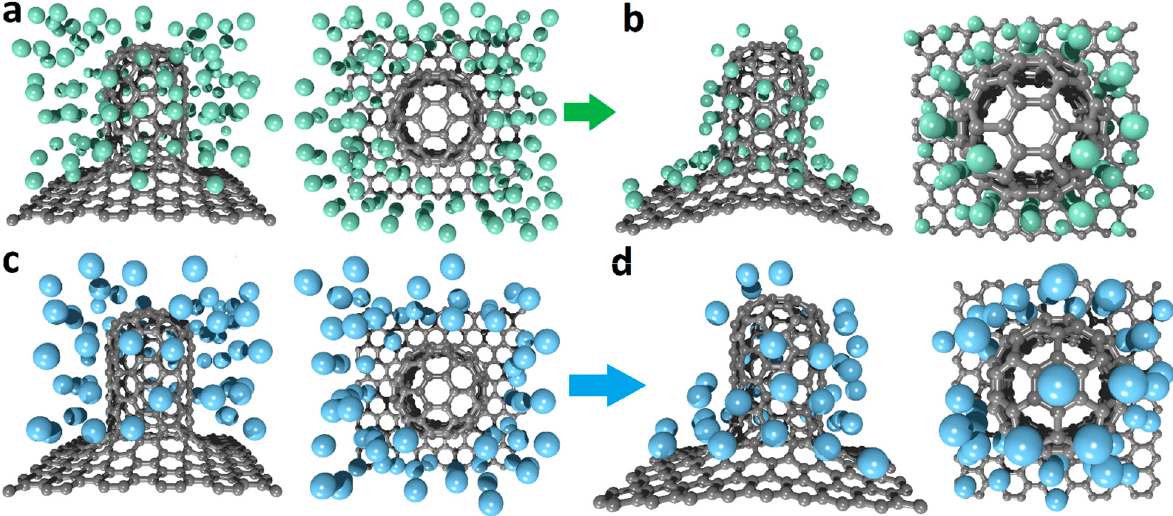
Figure 3. The process of filling the graphene–CNT composite with Li or Na atoms ( a , b ) and its ground state atomic structures ( c , d ).